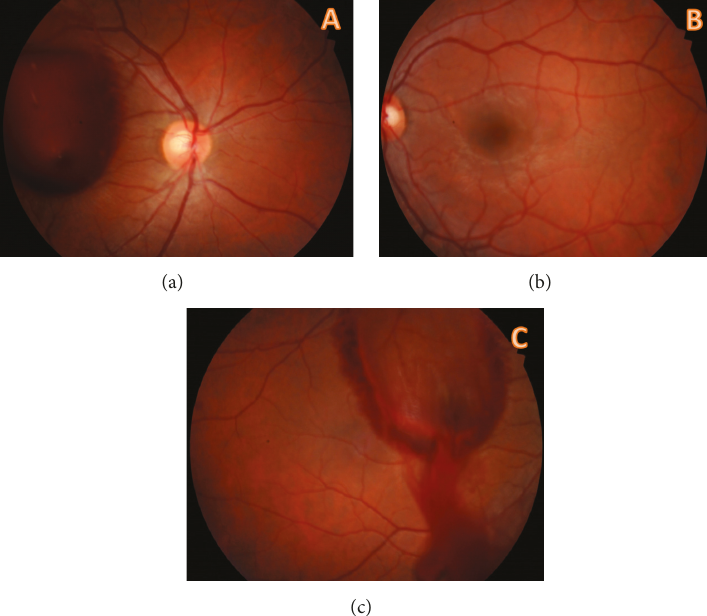
Figure 1: Fundus photographs which were screened in the second care clinic. (a) Premacular hemorrhage was seen in the right eye of the patient. (b) Normal macula of the left eye. (c) After the Nd:YAG laser hyaloidotomy treatment, evacuation of blood from subhyaloid space was seen in the right eye.